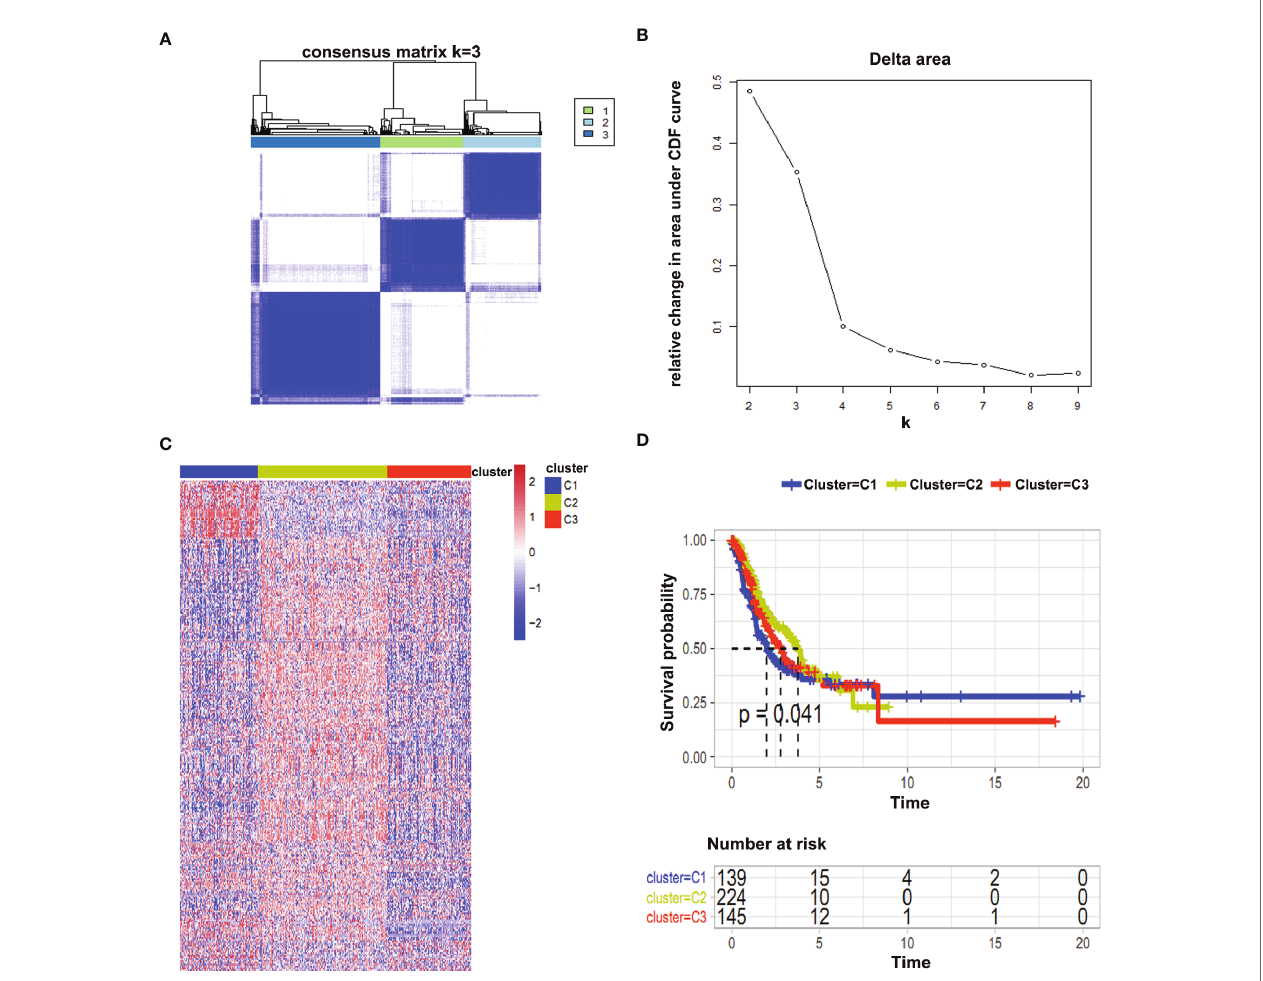
FIGURE 3 | Consistent clustering of immune-related metabolic genes. (A, B) Cumulative distribution function (CDF) represented an optimal number of clusters (k is 3); (C) Heat map represented immune-related metabolic genes in three clusters; (D) Survival analysis between different clusters was